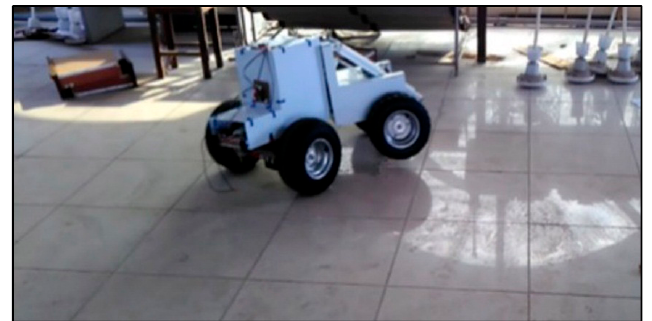
Figure 17. Steady-state rotation test site.